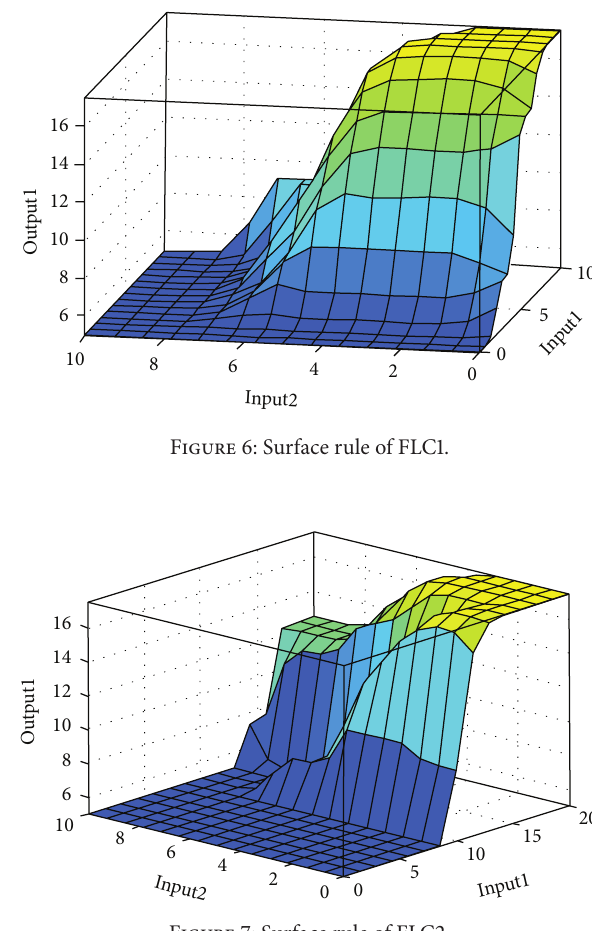
Figure 7: Surface rule of